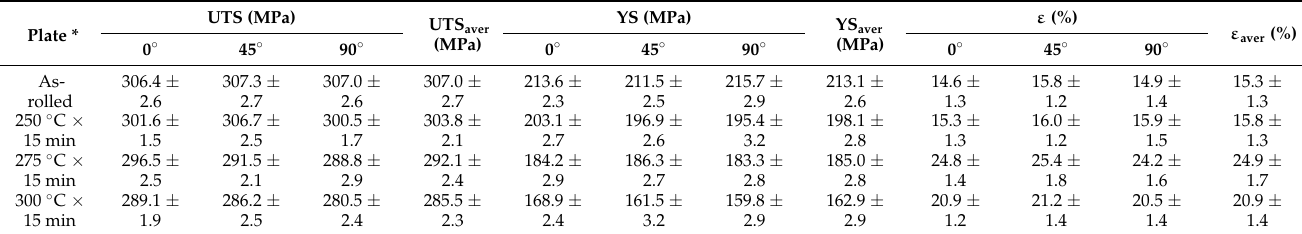
Figure 8. In-plane engineering stress-strain curves of the as-rolled plate and annealed plates in the tensile directions of ( a ) 0°, ( b ) 45°, and ( c ) 90° relative to the RD, and ( d ) the trends of the ultimate strength and elongation to failure in the three directions. Table 2. Results of Tensile Testing of the Mg-6Al DSR Samples Carried out along 0°, 45° and 90°.